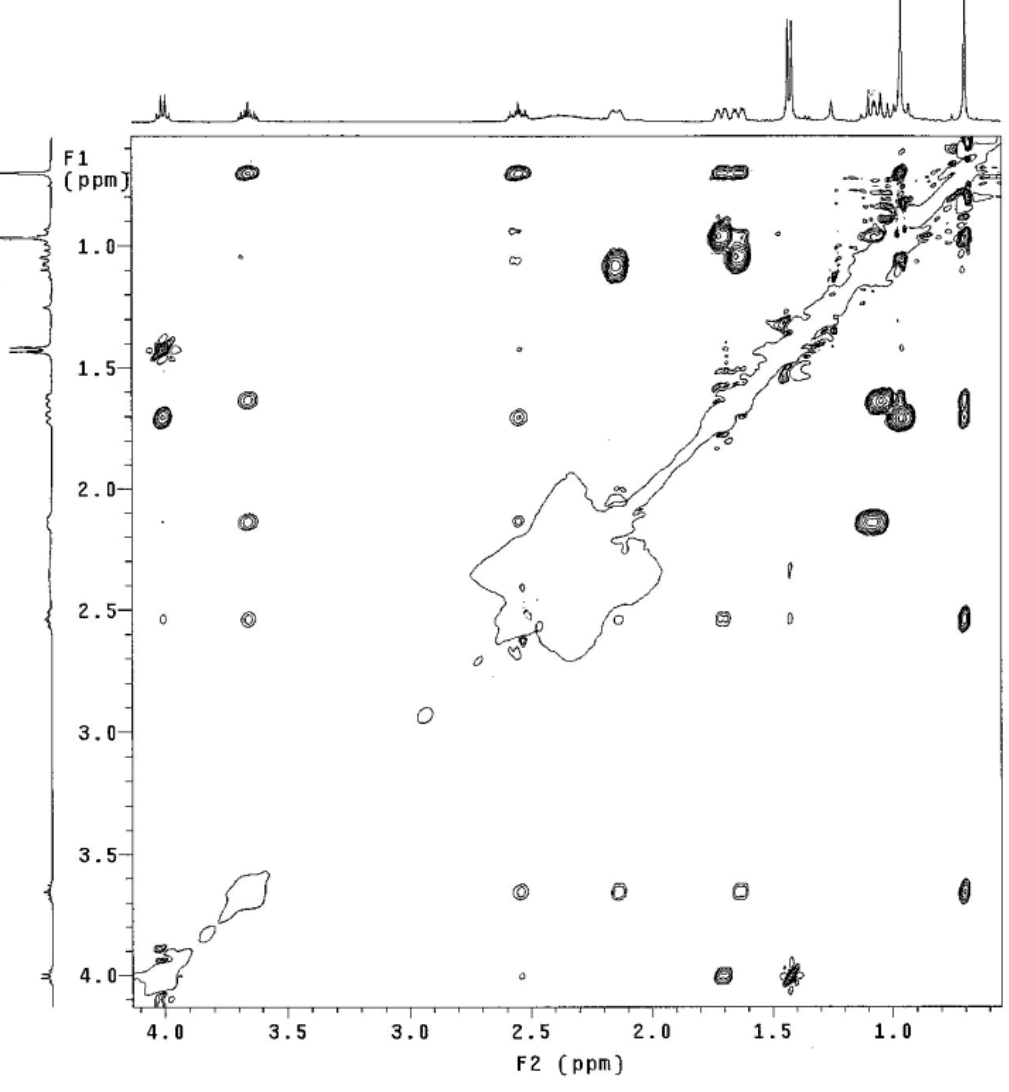
Figure 5. Multiplicity of the protons H